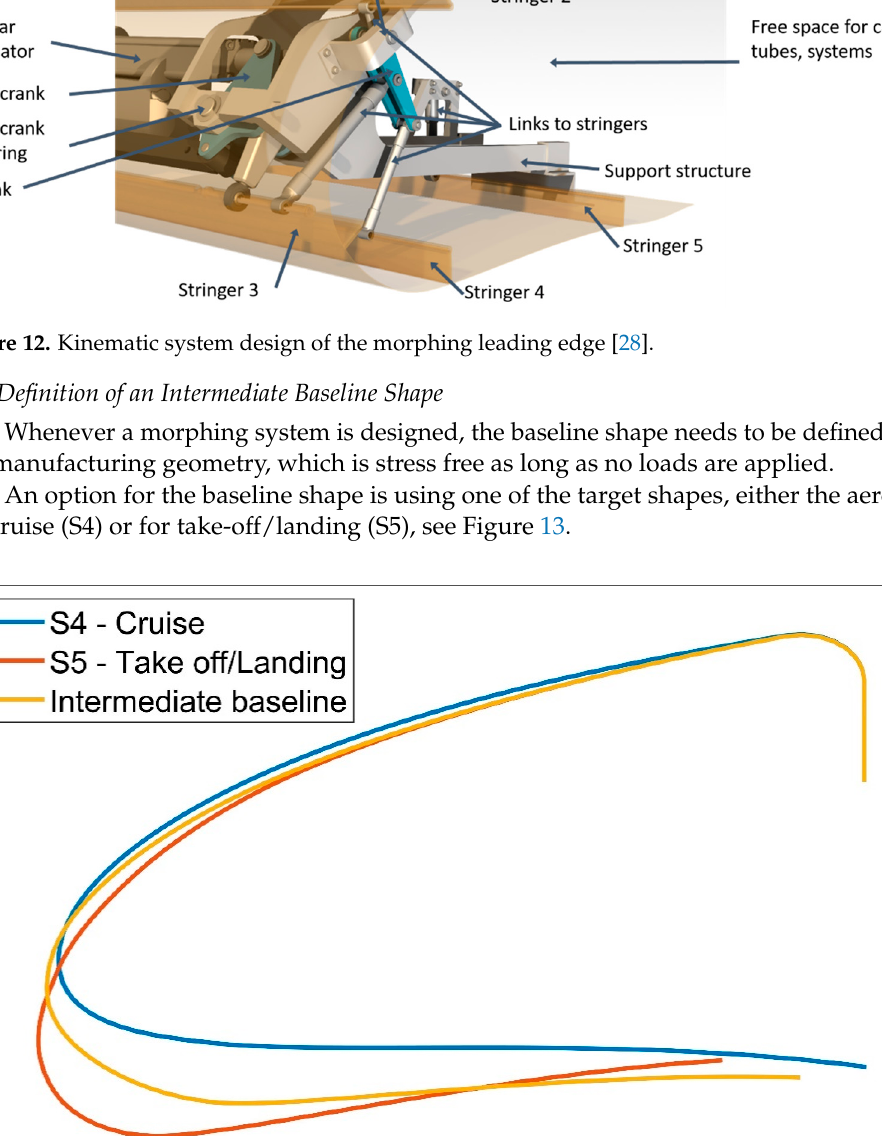
14 of 29 Figure 11. Steel profiles for additional stiffening of the stringers; stringers 1, 2, 4, and 5 are rein- forced by a pair of C-section profiles, each, while higher loads at stringer 3 require box-section profiles; cylindrical parts are fittings for the kinematic system; stringer 1 is not connected to the kinematic system and therefore does not possess fittings; the CFRP-portion of each stringers (not shown here) is sandwiched between the two profiles. 4. Actuation System Several options exist for actuating the MLE system. Besides classical actuators like